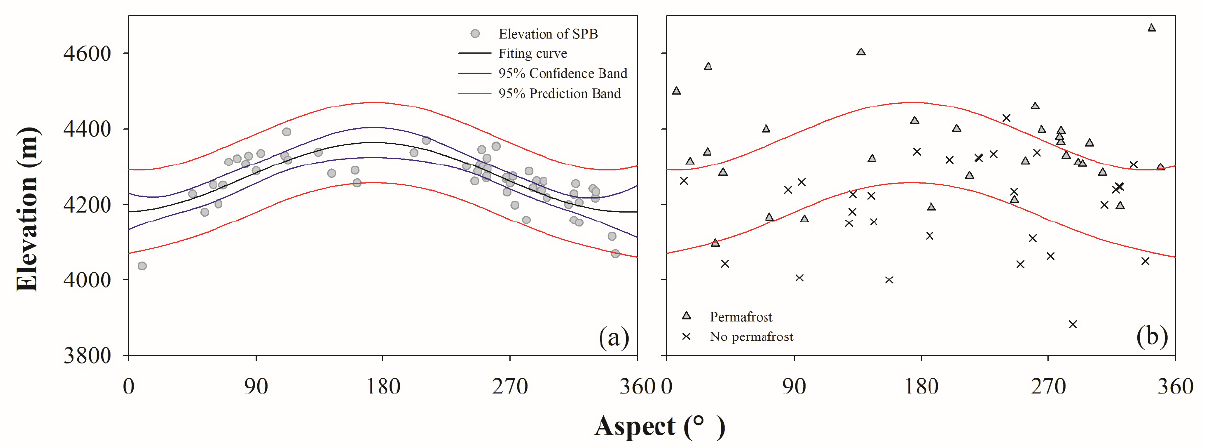
Figure 8. ( a ) The curve fitting between elevations of the suspected permafrost boundary (SPB) and the slope orientations based on the interpretation results of the ground-penetrating radar (GPR) profiles; ( b ) the curve of the upper and lower limits of the prediction interval and the information of the field survey sites.